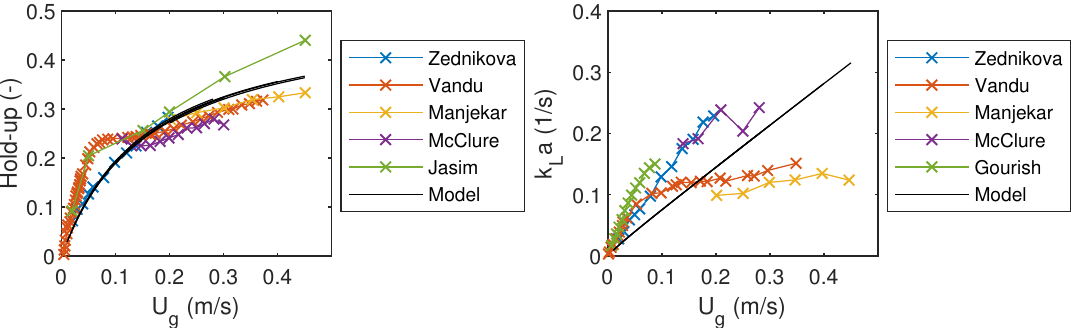
Figure 2. Comparison of the model results to the experimental results from